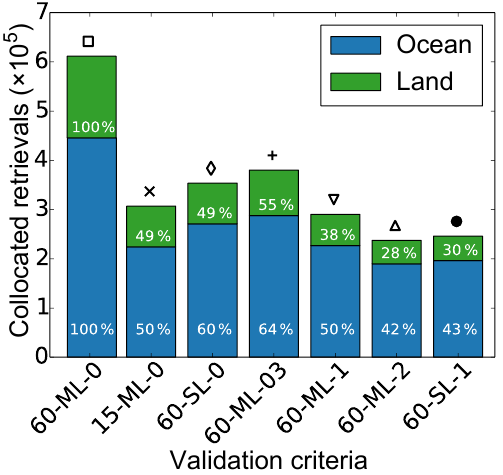
Figure 4. Number of SEVIRI and CALIOP retrievals collocated in 2007 for each of the collocation criteria defined in Table 1. Collo- cation criteria are identified by both text abbreviation and symbol. Colours show the division between land (green) and ocean (blue) retrievals. Percentages show what fraction of the total number of available retrievals are processed for each set of collocation